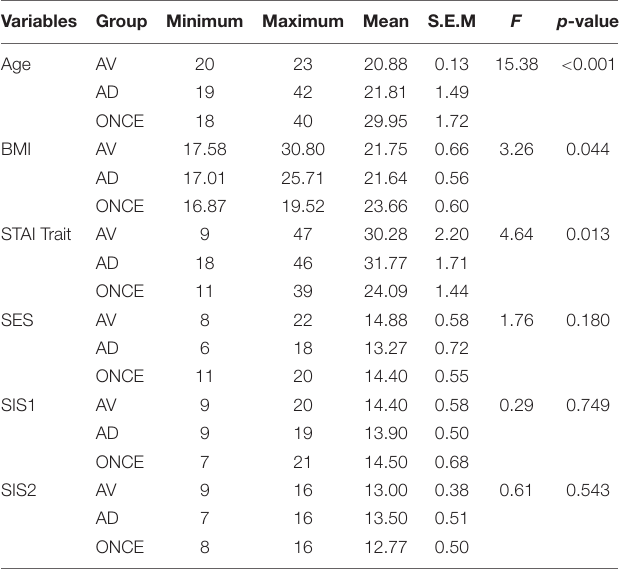
TABLE 2 | Statistics for anthropometric and demographic variables for the full sample (AV = 25; AD = 22; ONCE = 22). Variables Group Minimum Maximum Mean